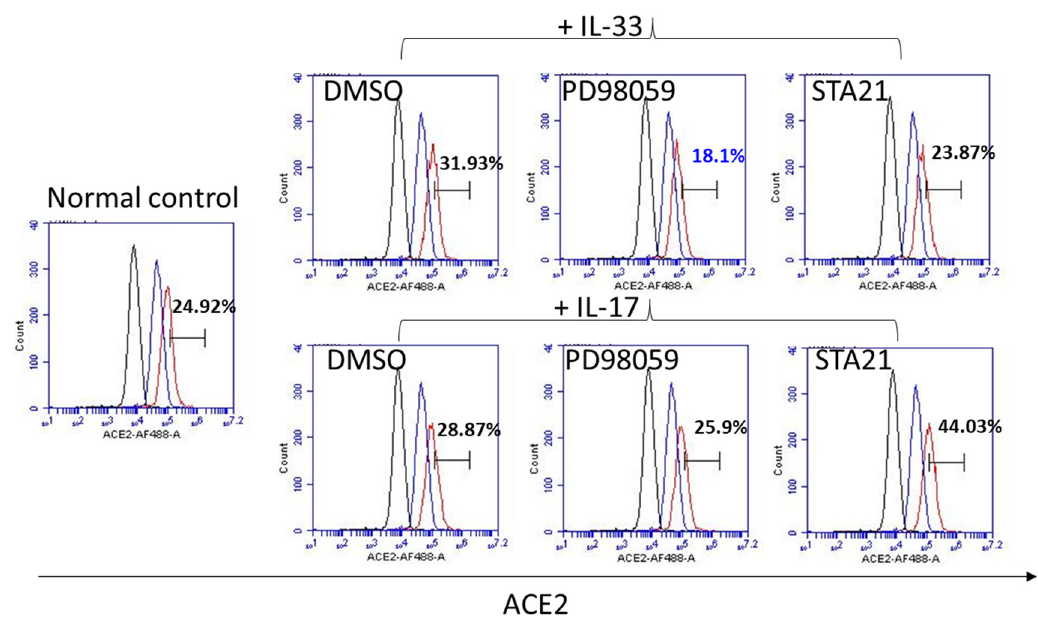
Figure 5. IL-33 enhanced ACE2 expression through ERK in keratinocytes by flow cytometry. With a similar experimental design, we performed flow cytometry to measure ACE2 expression in IL-33- treated keratinocytes. Small molecule inhibitors for PD98059 or STA21 (ERK and STAT3, respectively) were pretreated in order to investigate the role of ERK or STAT3 in IL-33-induced ACE2 expression. The data showed that IL-33 induced a modest expression of ACE2, which was abrogated by both PD98059 and STA21. Interestingly, while IL-17 induced a minimally increased expression of ACE2, the pretreatment of STA21 potentiated the expression of ACE2 by IL-17.